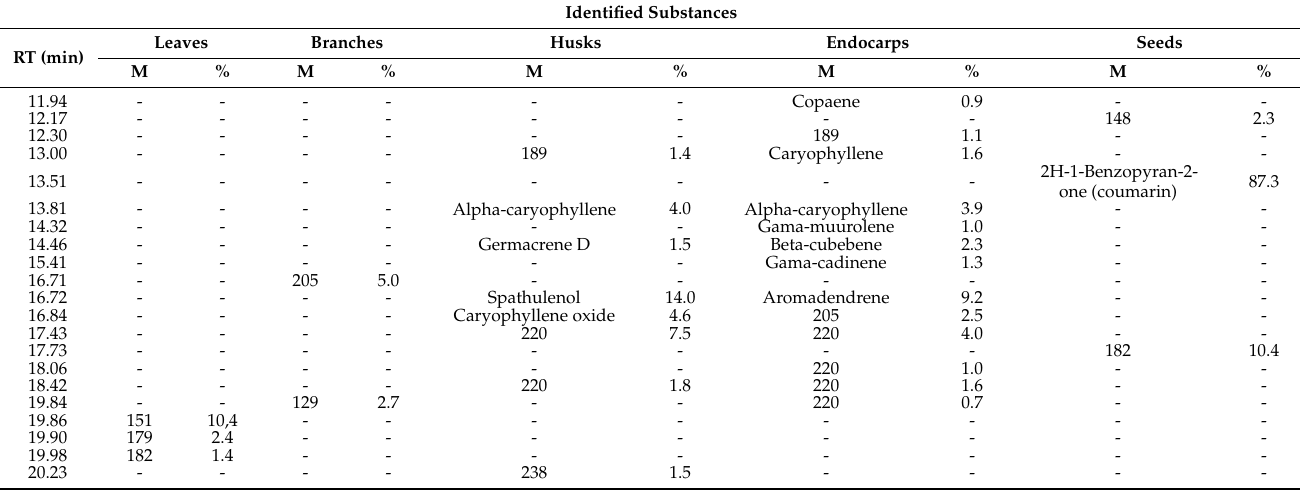
Table 2. Chemical constituents of ethanolic extracts of Dipteryx odorata characterized by gas chro- matography coupled to mass spectrometry